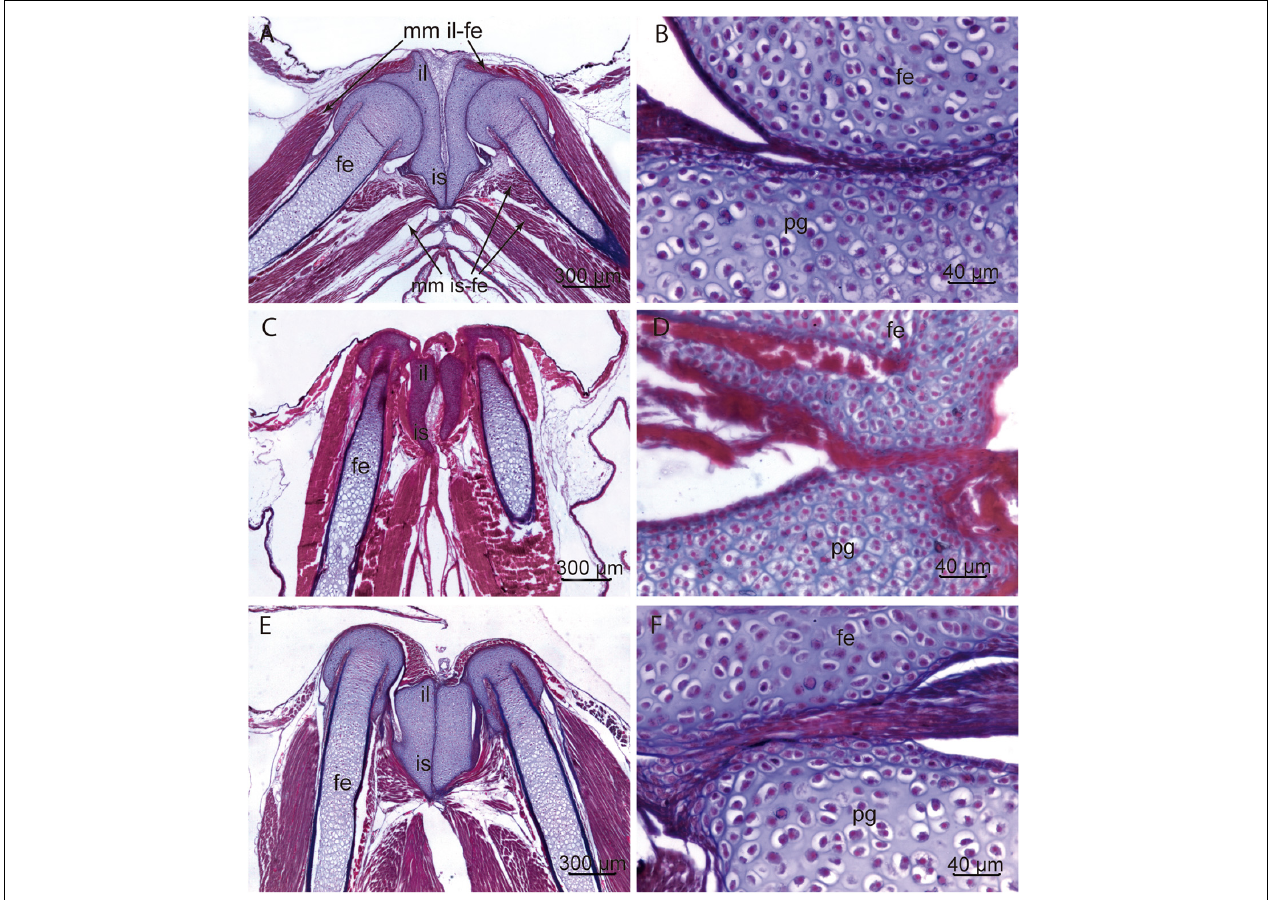
FIGURE 9 | Histology of pelvic girdles. (A,B) Control specimen (Gosner Stage 39). Section of the ilium-ischium cartilage. Each hemigirdle contacts with the opposite at the mid-ventral line. Epiphyses of the femur are well defined and fit in the acetabulum. The diaphysis of the femur is formed by hyaline cartilage with hypertrophic chondrocytes and incipient perichondral ossification. The epiphysis of the femur and the pelvic cartilage present abundant chondroblasts rounded by extracellular matrix. The organization of the thigh musculature is advanced. (C,D) Methimazole treated specimen (Gosner Stage 39). The rudimentary differentiation of femoral epiphyses and pelvic girdle indicates a delayed local development with the proliferation of chondroblasts, concomitant with a scarce extracellular matrix. The atrophy of muscles attached to the ilium, ischium, and proximal segment of the femur is evident. (E,F) Specimen exposed to T4 (Gosner Stage 39). The asymmetry of ilium-ischium cartilage and the absence of acetabulum precludes the articulation of hind limb. The asymmetry is also observed in the associated muscles. The histology of cartilage shows a pattern of chondrogenesis similar to control specimens. fe, femur; il ilium; is, ischium; mm il-fe, muscles originated in the ilium and inserted on the femur muscles; mm is-fe, muscles originated in the ischium and inserted on the femur; pg, pelvic